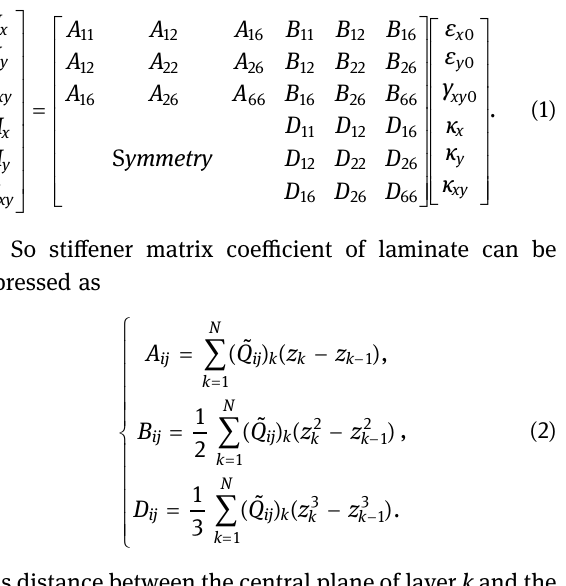
Figure 12: The laminates layup of the